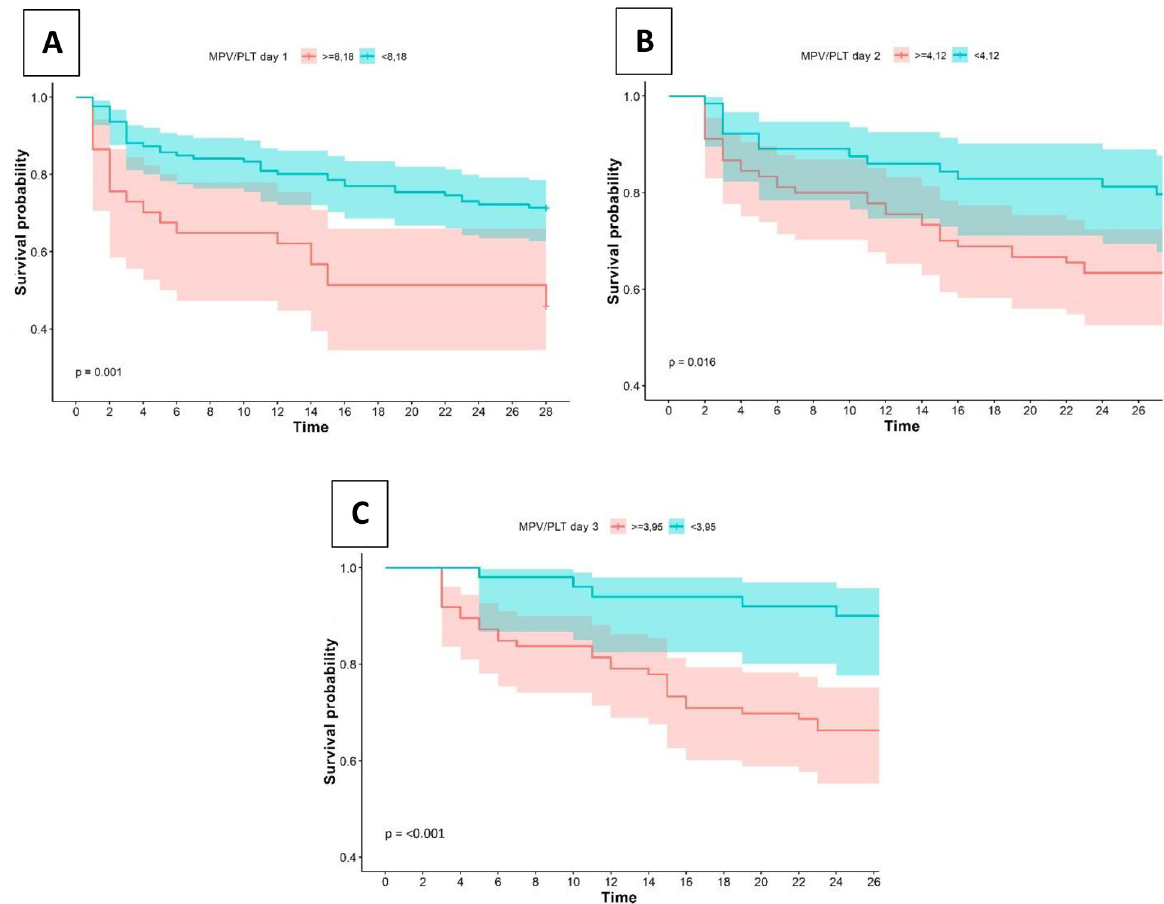
Fig 6. Cumulative survival curve of septic patients by MPV/P ratio cut-off at day 1 (A); 2 (B); 3 (C).